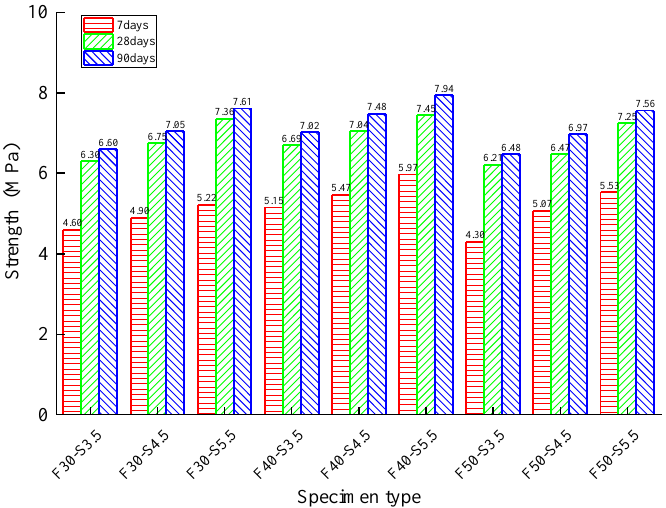
Figure 11. The relationship between axial compressive strength and curing time for various speci- mens.